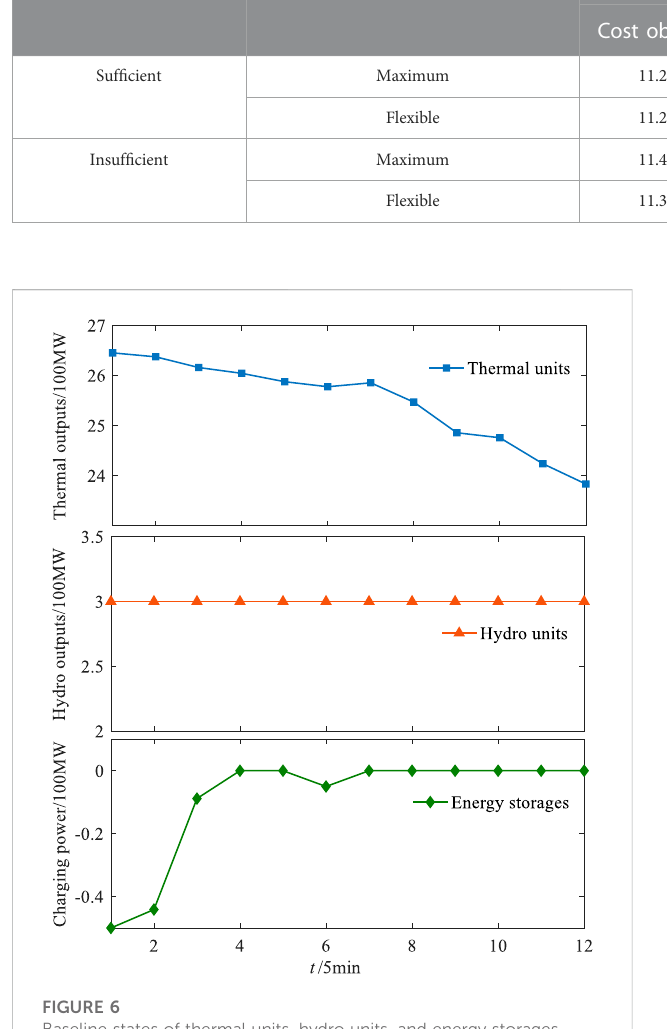
security. Figure 4 and Figure 5 present the allowed upper bounds (UB